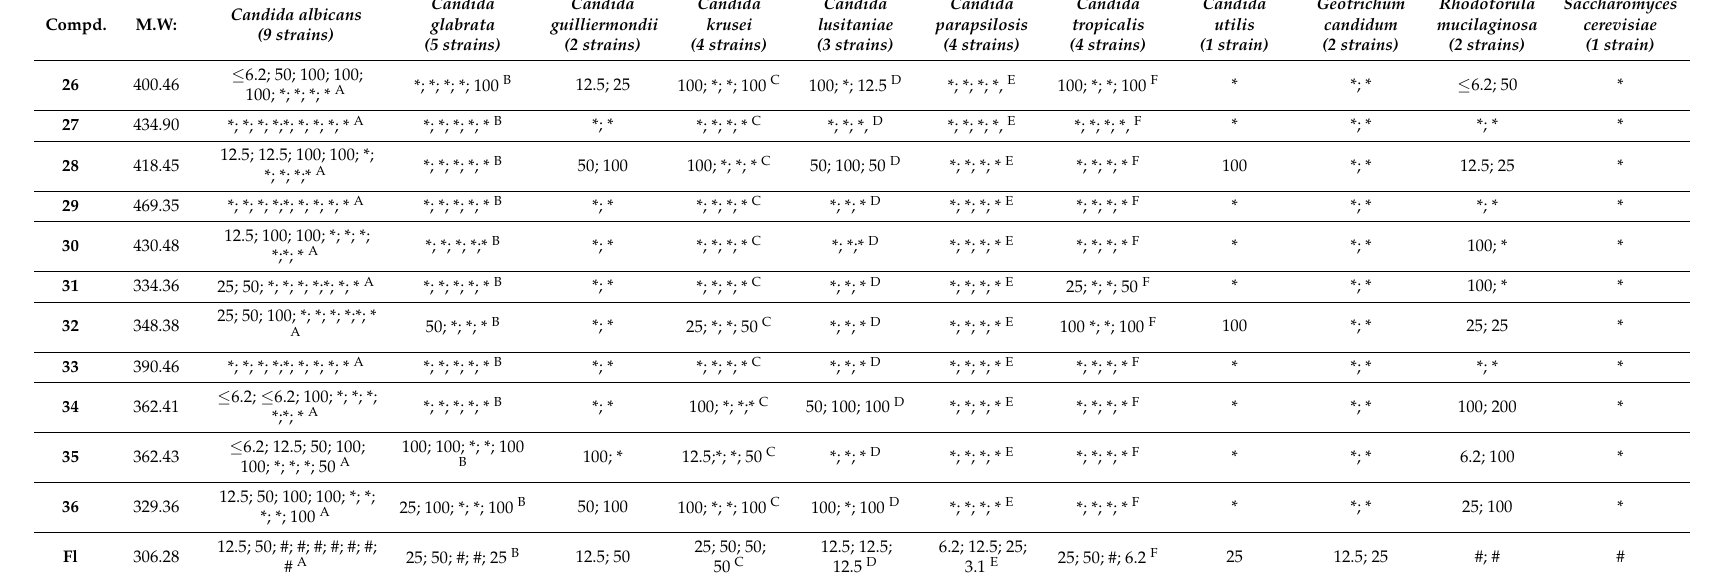
Table 1. The MIC values ( µ g/mL) obtained for compounds 26 – 36 and fluconazole ( Fl ) against yeast strains used in assay.